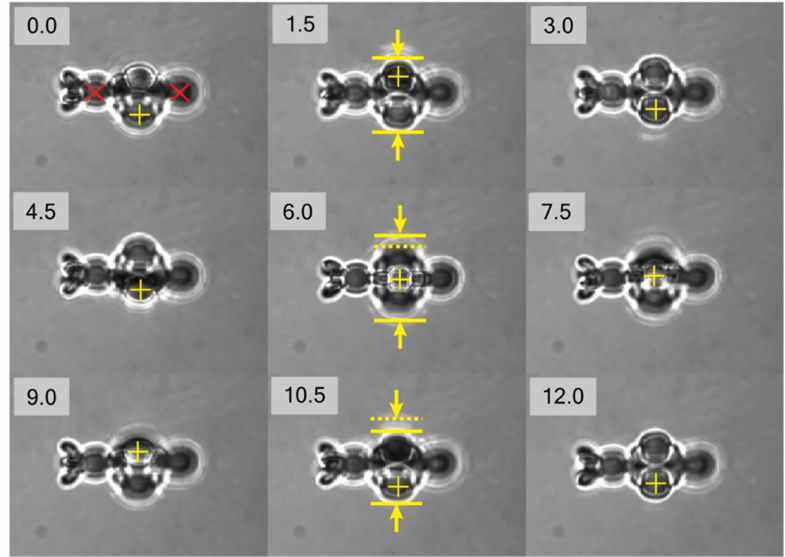
Figure 2. Frame sequence obtained from captured video demonstrating rotation of a trapped single micro-tool. Frames were extracted every 1.5 s. Red crosses in frame at 0 s mark immobilization trap positions. Yellow crosses mark positions of displaced microspheres. The solid and dotted yellow lines shown in frames for 1.5, 6, and 10.5 s reveal variance of one of the dimensions of projection of the microtool captured by